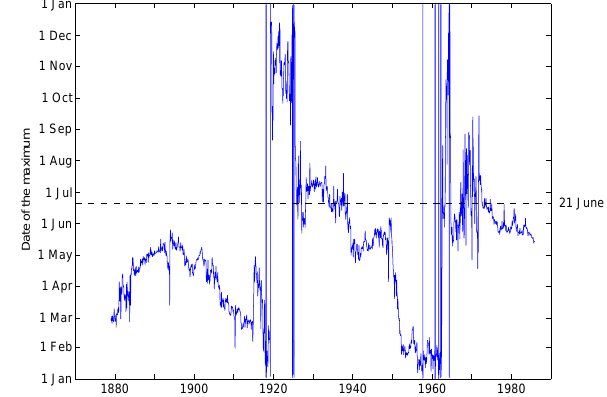
Fig. 7. Time variation of the phase of the aa -index annual varia- tion, computed using a 22-year sliding window, centered. The phase is reckoned as the date of the